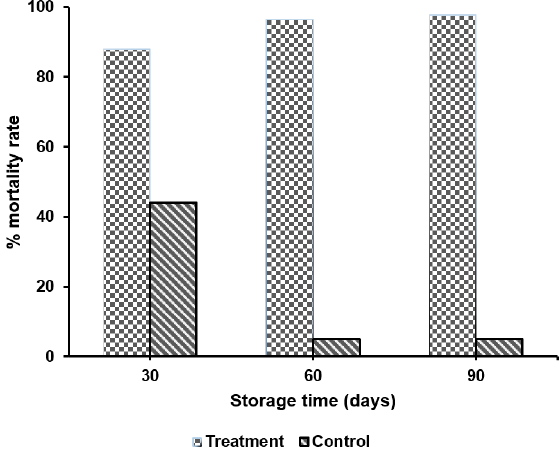
Figure 2. The overall effect of physical disturbance on S. zeamais mortality rate for treatment and control.